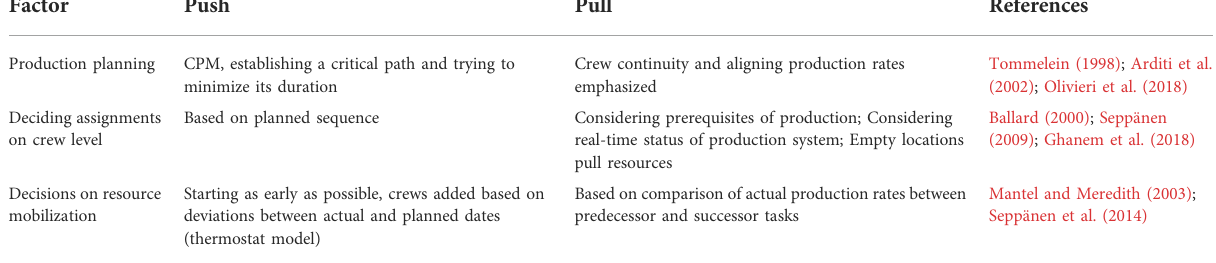
TABLE 1 Key differences between push and pull in construction projects. Factor Push